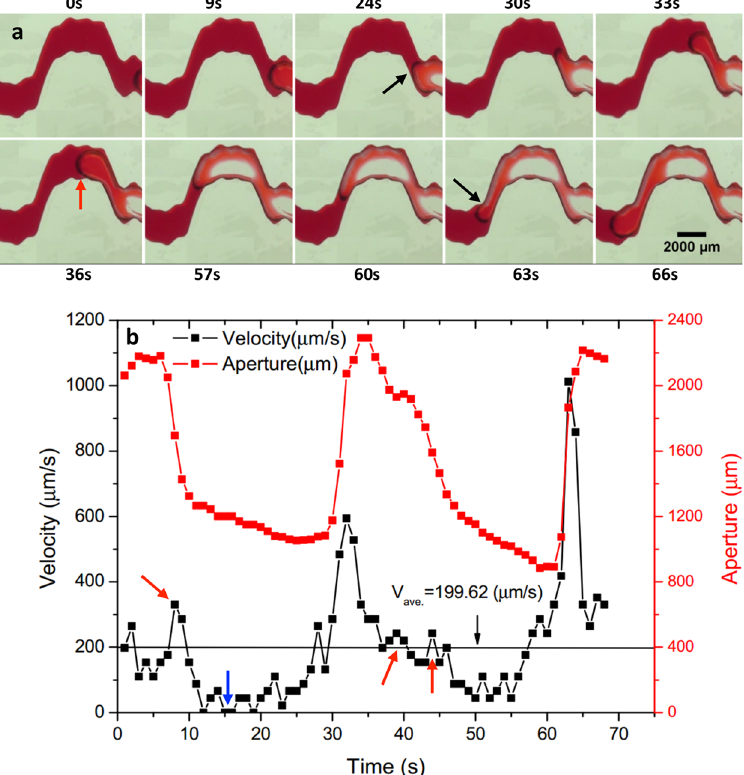
Figure 4. ( a ) Time-lapse images showing interfacial dynamics in the selected aperture geometry: Dual-phase combination (Dual-combo for short). ( b ) Temporal changes in interfacial velocity and corresponding aperture width. The black arrows in ( a ) indicate the two narrow “throats” at the inflection zones, while the red arrow indicates the wide “body”. The red arrows in ( b ) mark the smaller velocity increase at the jump intervals, while the blue arrow indicates the zero velocity as the interface invades the narrow throats for pressure